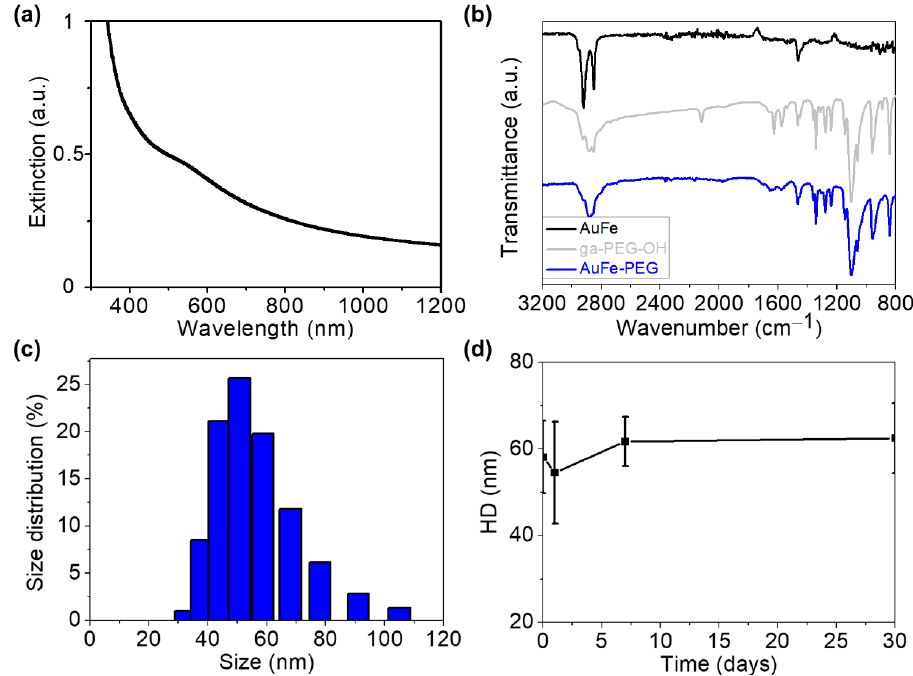
Figure 2. ( a ) UV–Vis–NIR spectrum of Au@Fe NPs. ( b ) FTIR spectra of oleic acid capped Fe@Au NPs (black), PEGylated ligand (gray), and PEGylated Fe@Au NPs (blue). ( c ) Hydrodynamic diameters in saline of Au@Fe ‐ PEG NPs. ( d ) Stability measured over time.